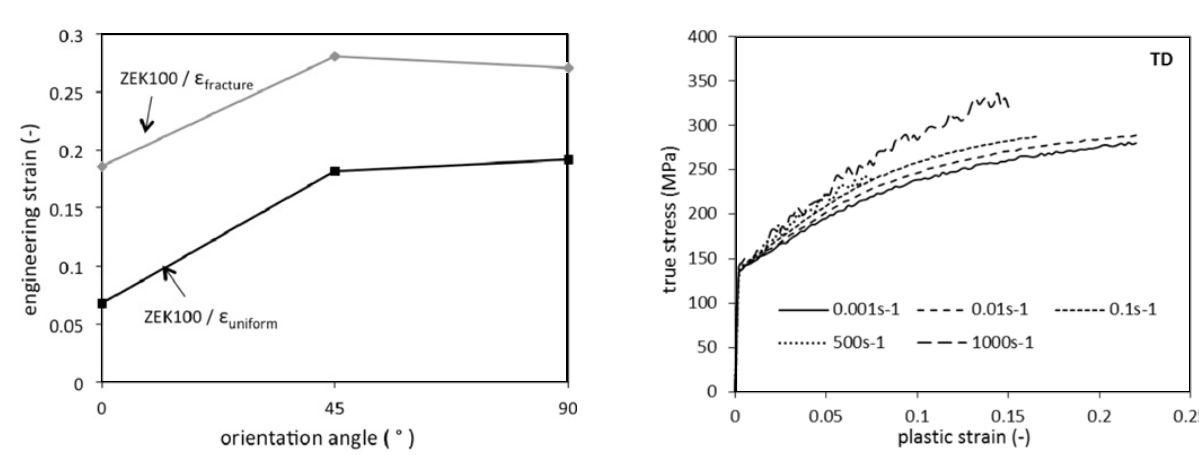
Fig. 9. E ff ect of orientation on uniform elongation and fracture strains for ZEK100 sheet at a strain rate of 0 . 1s − 1 .